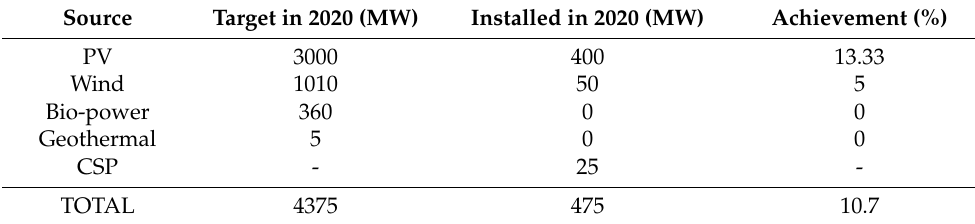
Table 6. National RE program target installation and